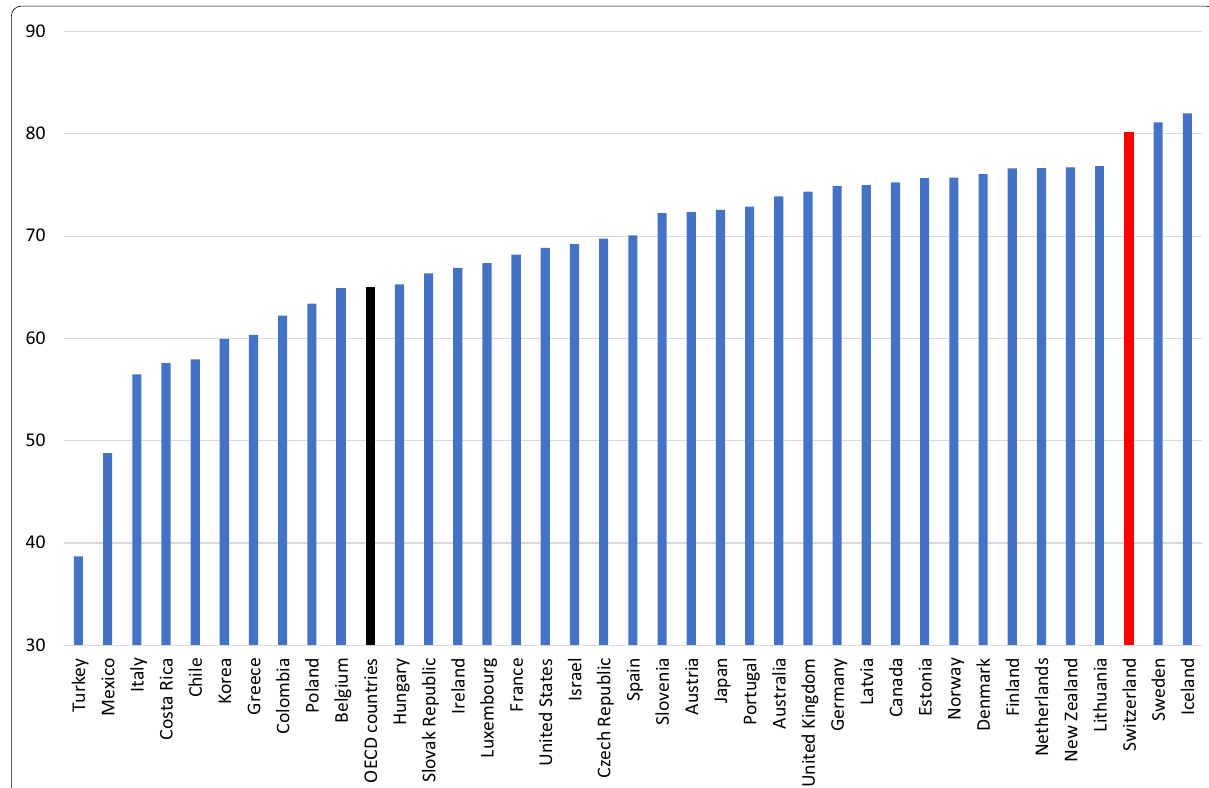
Fig. 3 Female labor market participation (2019). Notes Data from the OECD labor force statistics. The labor force participation rates are calculated as the labor force divided by the total working-age population